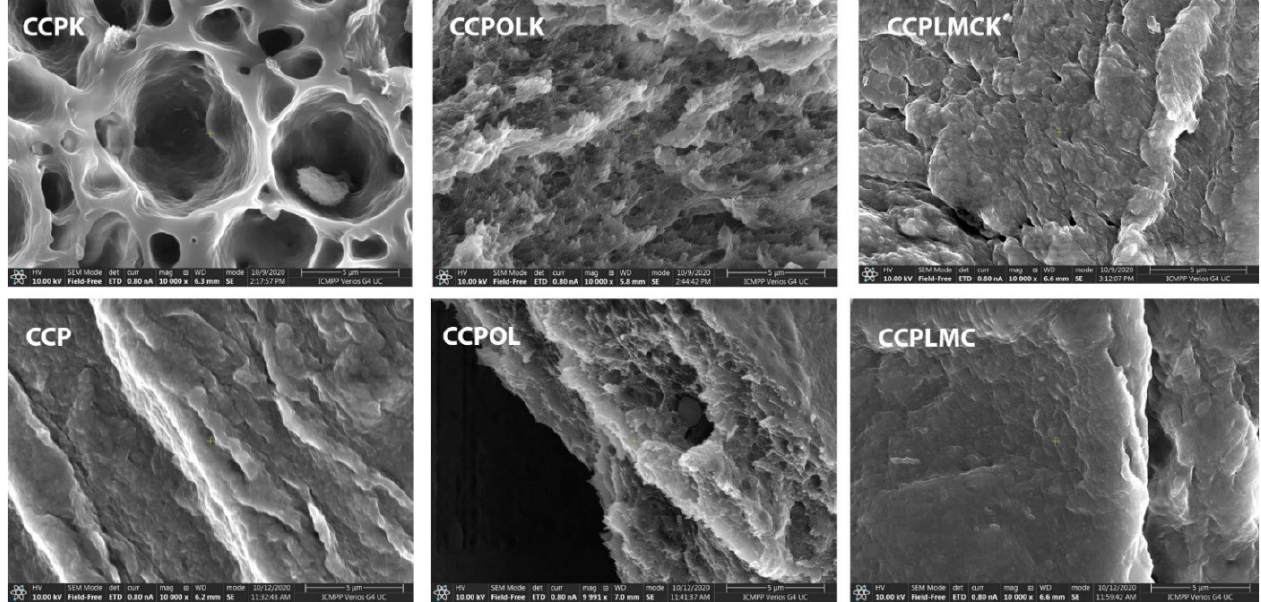
Figure 6. SEM images of the materials.